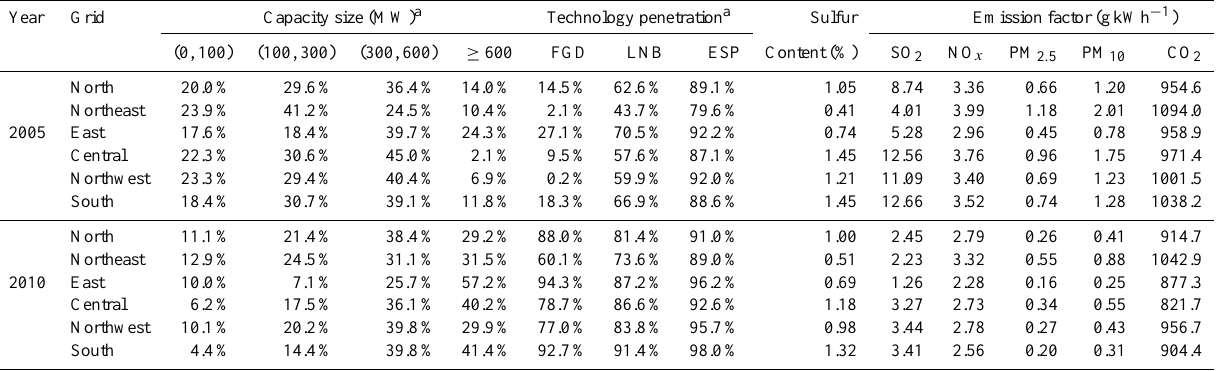
Table 5. Capacity sizes, technology penetrations, and emission factors of coal-fired power plants in China’s six interprovincial power grids in 2005 and